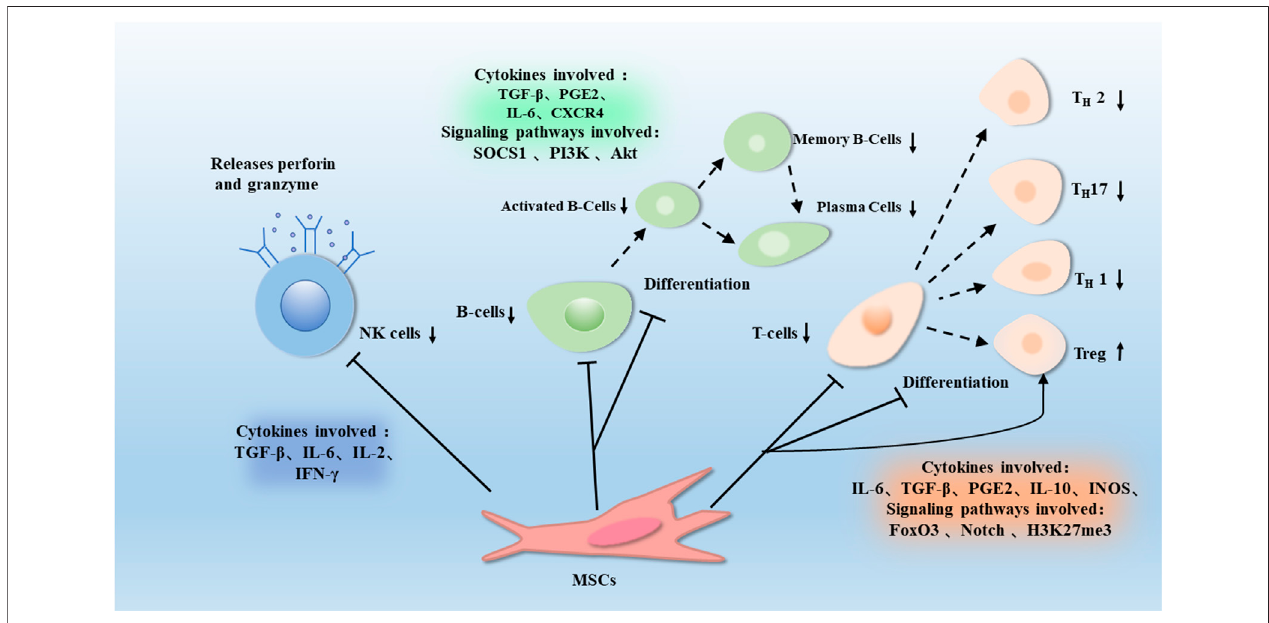
FIGURE2 | T cells can divide into different subpopulationsduring immune regulation, such asTh1, Th7, Th2, and Tregs. MSCs could inhibit suppression ofT cells proliferation and differentiation, and induce Tregs through proteins such as H3K27me3, Notch and FOXP3. This effect is associated with the release of Soluble factors such as TGF- β , IL-10, PGE-2, IL-6, and IDO. MSCs gradually differentiate into B cells, which can differentiate and proliferate into plasma cells. MSCs inhibit the proliferation ofB cells and antibody production through proteins such as Socs1, PI3K, and Akt, which are associated with factors such as TGF- β , PGE2, IL-6, and CXCR4. MSCs also promote the release of perforin and granzyme from NK cells, thus promoting the degranulation of NK cells, which is associated with factors such as TGF- β , IL-6, IL-2, and IFN- γ .